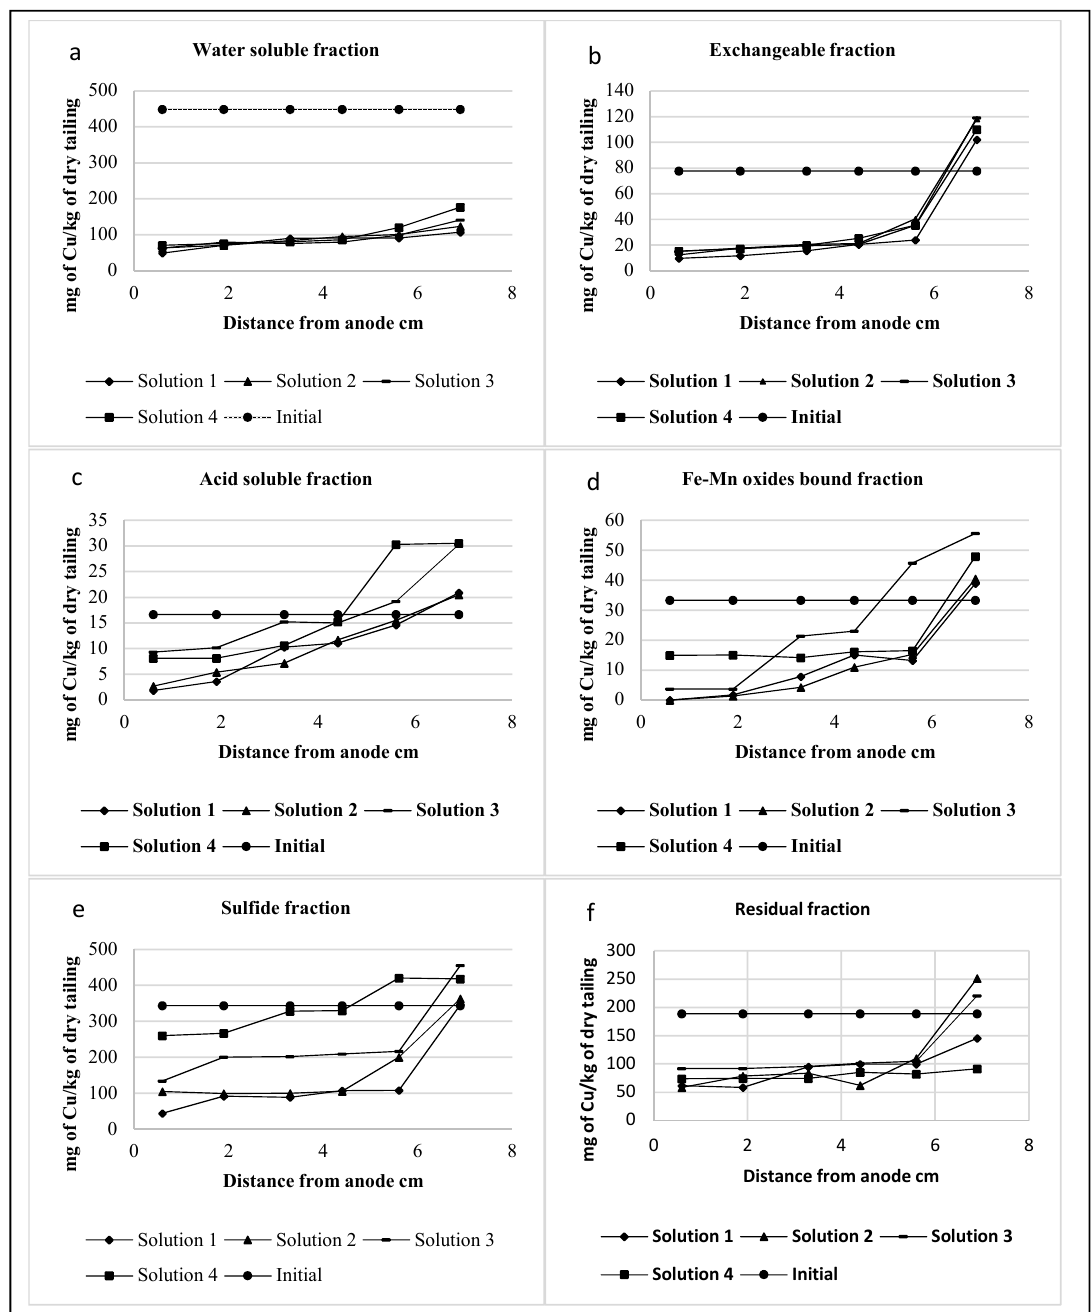
Figure 3. Copper associated to a ) Water-soluble fraction, b ) Exchangeable fraction, c ) Acid soluble fraction, d ) Fe-Me oxides bond fraction, e ) Sulfide fraction, f ) Residual fraction.